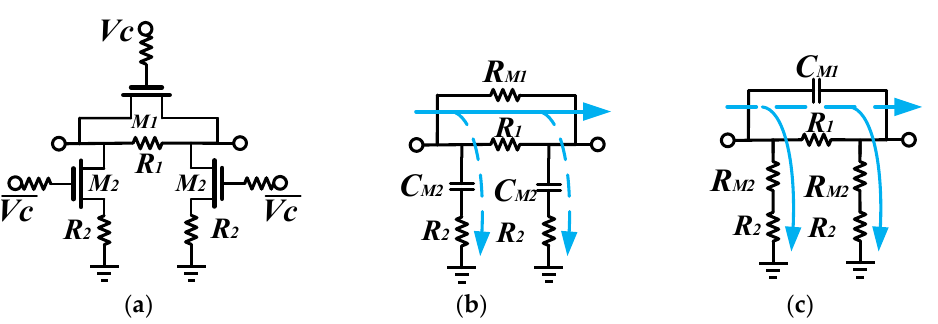
Figure 6. ( a ) The schematic of the conventional switched π -type attenuation cell. ( b ) Reference state. ( c ) Attenuation state.